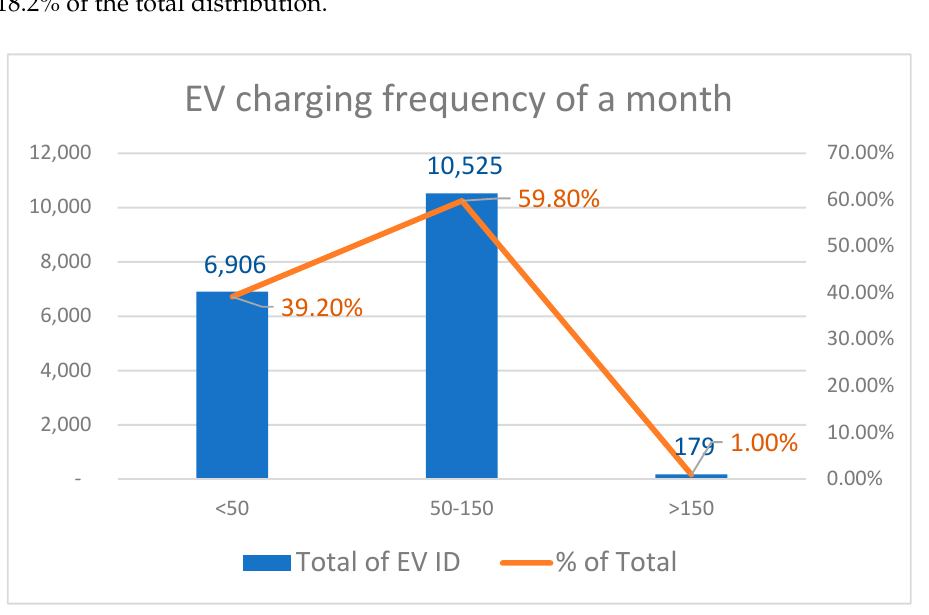
Figure 2. EV monthly charging frequency curve.